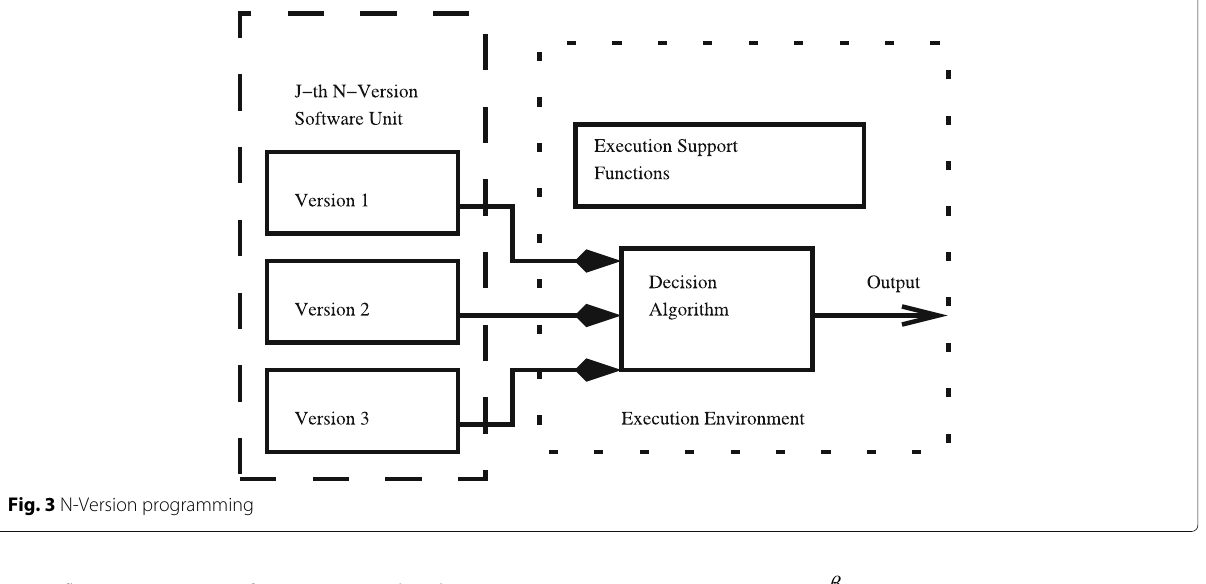
influence, in terms of interaction value, between C i and C j . Therefore, an interaction value of C i is derived from configurations that have invoked it for interaction. Interaction value of C i depends on (cid:2) (cid:3) (cid:2) (cid:3) | S ( C ) | , P C j I ji , M . The larger value of C i i indicates that it has been invoked very frequently by other configurations. Using Eq. 2 we find frequently used configurations of a software system. Value of α is varied between zero and one until we get stabilized interaction values for 10000 interactions.